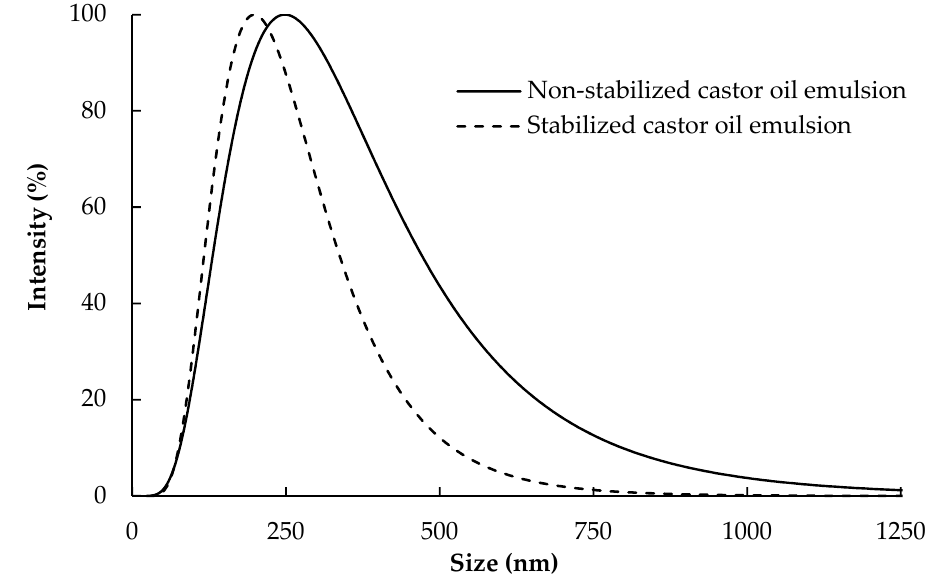
Figure 5. Gaussian distribution of diameter of stabilized and non-stabilized castor oil-in-water emulsions.